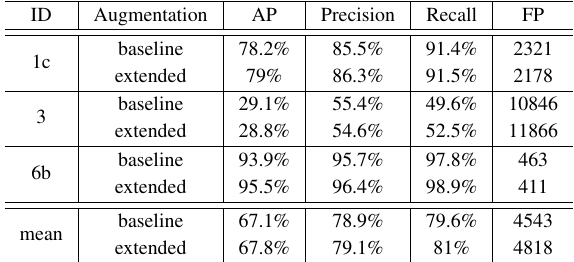
Table 3. Detection results. ID: the ID of the used video sequence. Augmentation: the type of the used